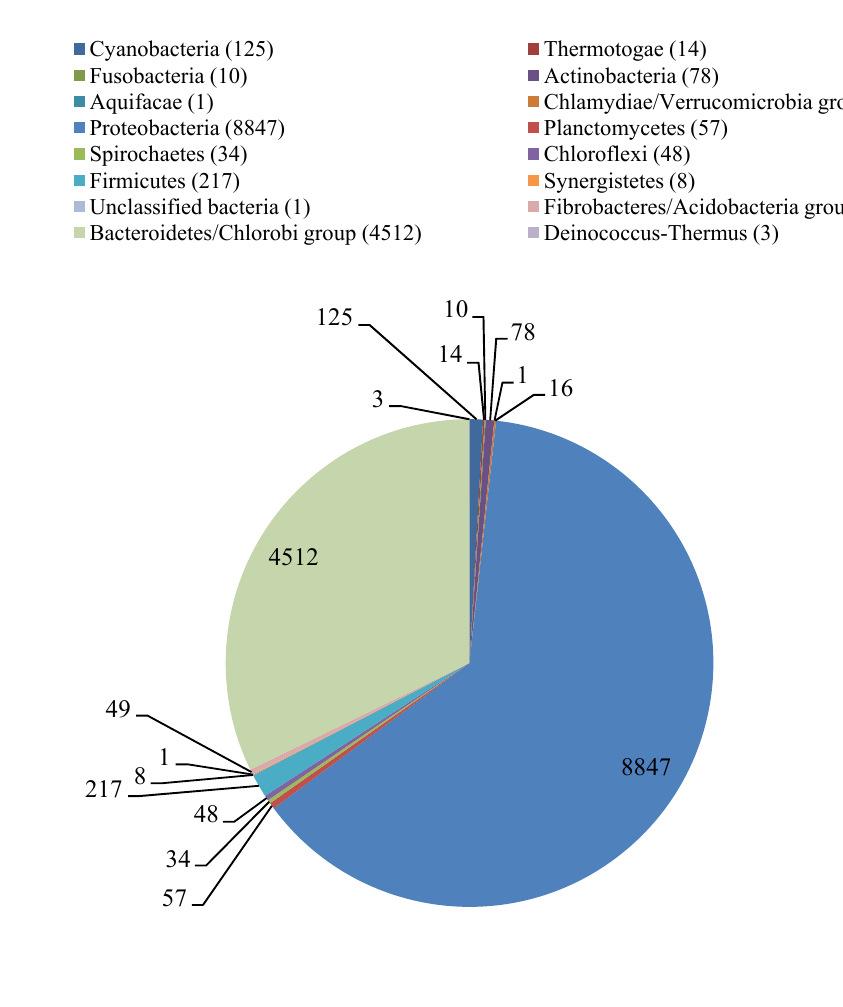
Figure 1. Summary of Phylum level taxonomic assignment of 14,020 assembled contigs matching protein encoding genes